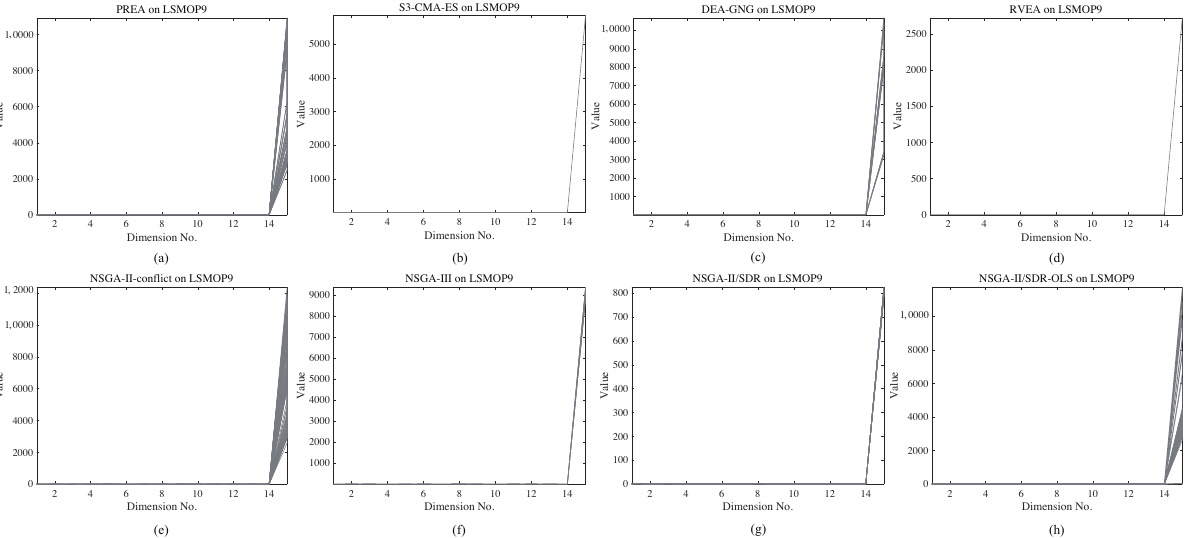
Figure 6. The final solution set obtained by NSGA-II/SDR-OLS and other seven algorithms on 15-objective LSMOP9. ( a ) The final solution set of PREA; ( b ) The final solution set of S3-CMA-ES; ( c ) The final solution set of DEA-GNG; ( d ) The final solution set of RVEA; ( e ) The final solution set of NSGA-II-conflict; ( f ) The final solution set of NSGA-III; ( g ) The final solution set of NSGA-II/SDR; ( h ) The final solution set of